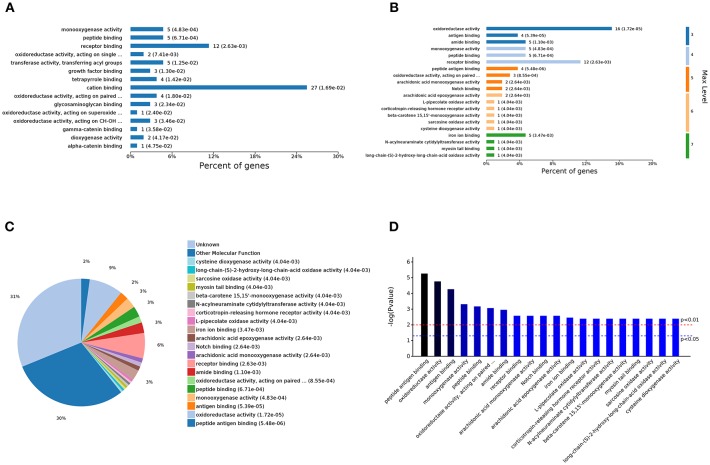
Analysis of 105 different molecular function GOs. (A) Percent of genes associated with enriched molecular functions. (B) Levels of enriched molecular functions. (C) Expressed proteins associated with enriched molecular functions. (D) Significantly enriched molecular functions.